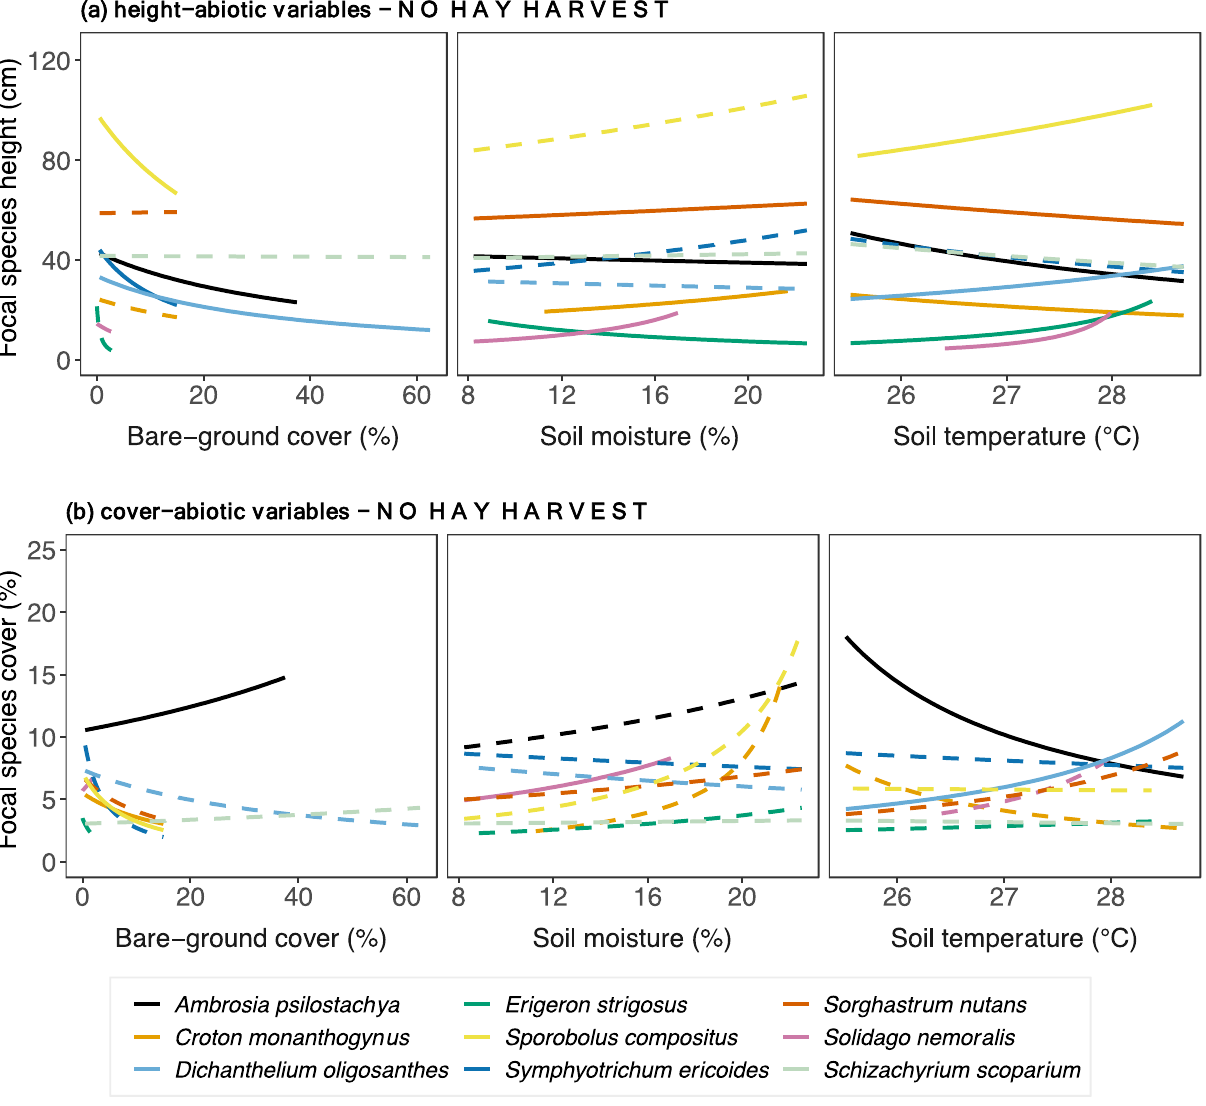
Figure 4. Focal species relationships between ( a ) height, ( b ) cover and abiotic variables relationships in plots with no hay harvest across the precipitation gradient. Relationships were estimated by fitting Generalized Linear Mixed Models with log link to both species-specific height and abiotic variables (soil temperature, soil moisture, bare-ground cover). Continuous lines indicate significant relationships, while dashed lines indicate non- significant. P -values are shown in Supplementary Table